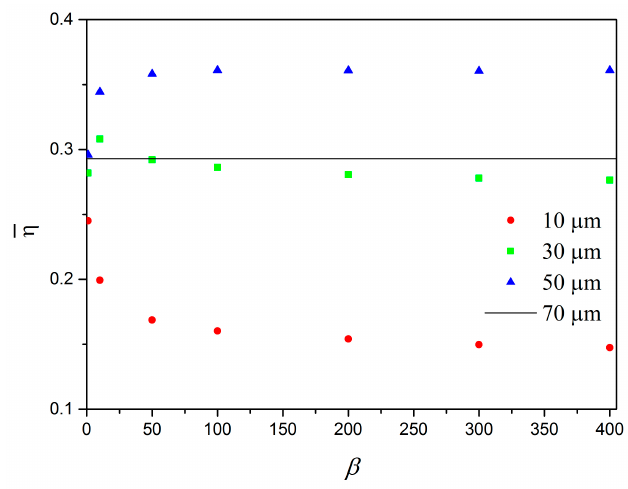
Figure 10. Average efficiency for different frequencies (interval of 500 to 1400 rad/s), for different values of gap, as a function of β